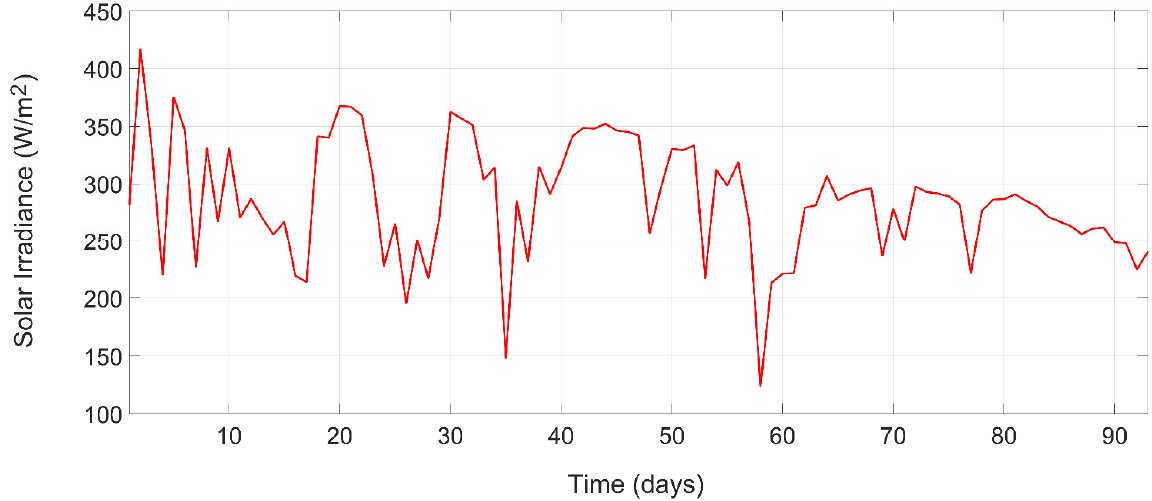
Figure 7. Solar irradiance readings during the experiment.